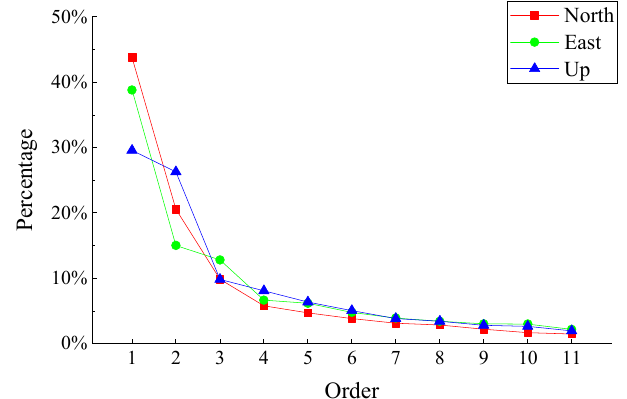
Figure 3. Percentage of the eigenvalue of each principal component to the total eigenvalue.